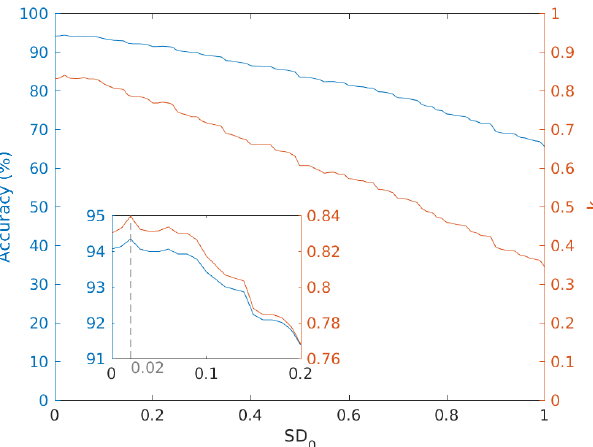
Figure 10. Sensitivity of the agreement between the in situ and Theia snow product to SD 0 in metres (threshold to convert the mea- sured snow depth to snow presence or absence). The inset shows a close-up of the region of